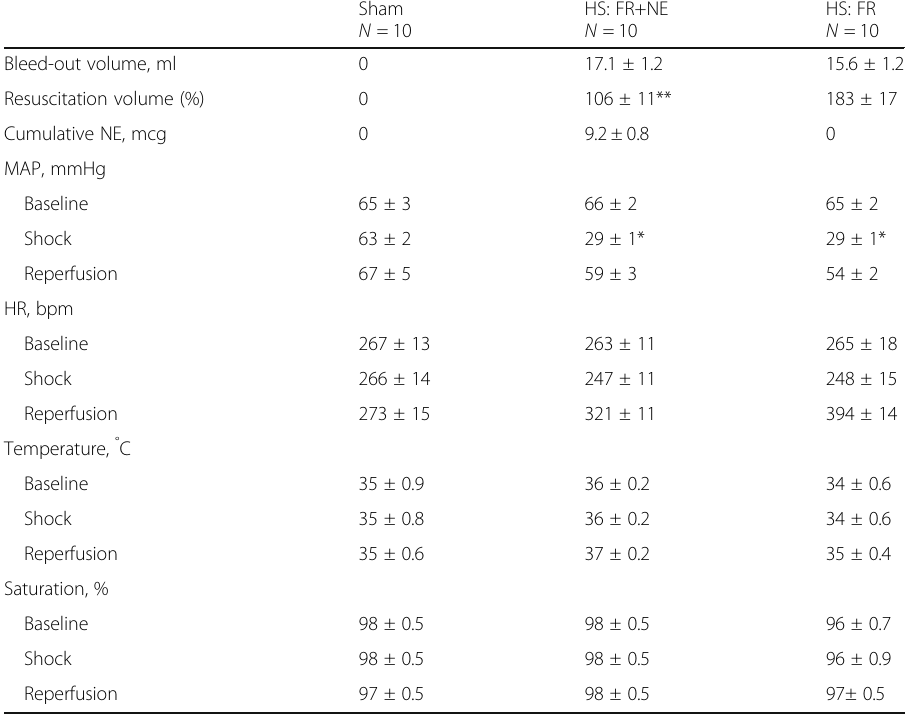
Data represented are those of animals who survived till their euthanasia. Values are reported as Mean±SEM, during each defined period. FR = fluid resuscitation, FR+NE = fluid with norepinephrine, MAP = mean arterial pressure, HR = heart